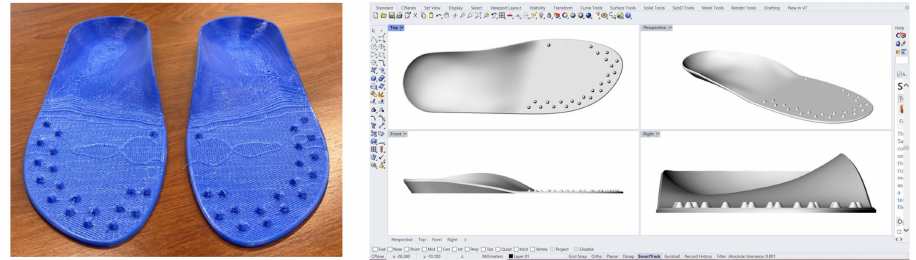
Figure 1. Detail of the 3D printed custom foot orthoses with the blunted cones positioned according to recent reports in the scientific literature